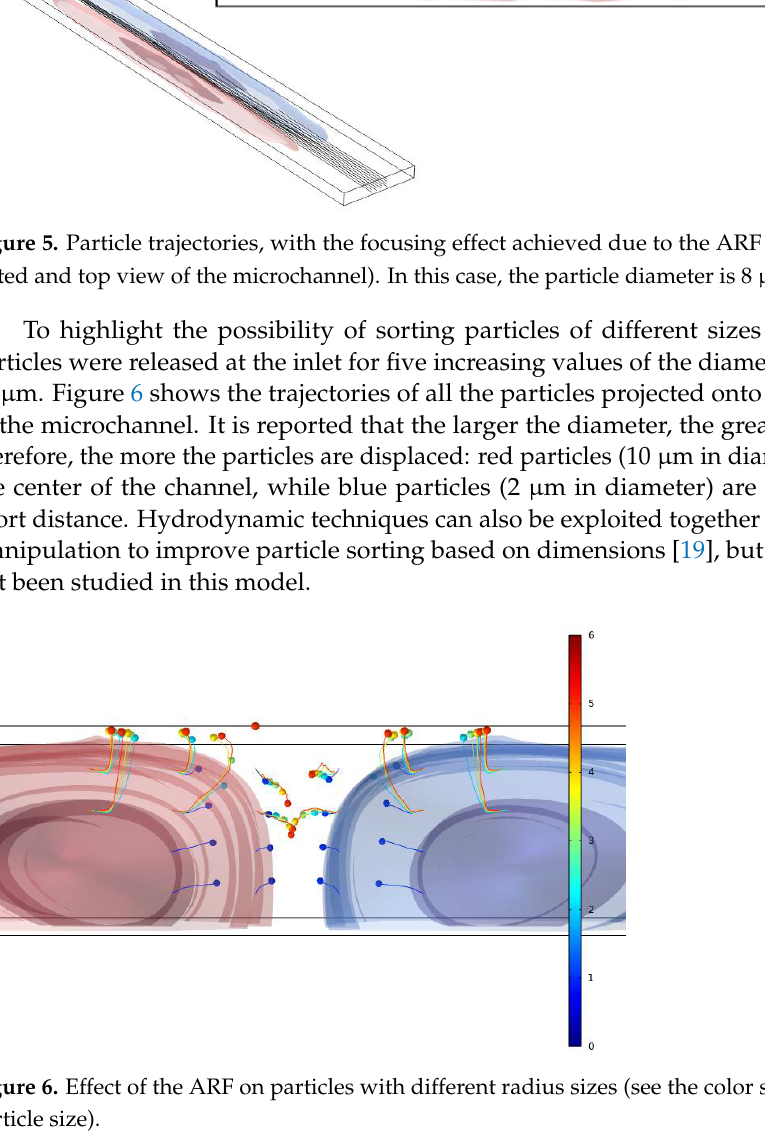
Figure 6. Effect of the ARF on particles with different radius sizes (see the color scale to identify the particle size).